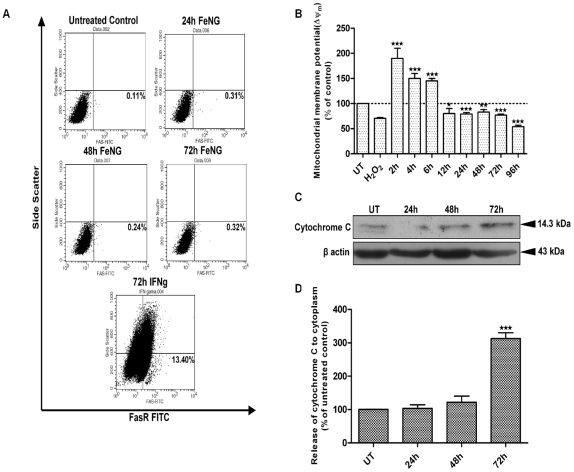
FeNG induces apoptosis through mitochondrial cell death pathway.(A) CEM/ADR5000 cells of both untreated and FeNG treated for indicated time or rIFN γ treated were labeled with anti FasR antibody. Immunofluorescence analysis was performed by flow cytometry. Representative data of 3 independent experiments is presented. (B) CEM/ADR5000 cells were treated with or without FeNG for indicated time, and mitochondrial membrane potential was measured after JC1 staining. The ratio of red fluorescence (mitochondrial JC-1) to green fluorescence (cytoplasmic JC-1) was used as a surrogate for mitochondrial potential. Data represent mean ± SD of three independent experiments. Statistically significant difference from untreated control at *P<0.05, **P<0.01, ***P<0.001, respectively. (C) Effect of FeNG on the release of cytochrome c. Western blot analysis of cytosolic extracts from CEM/ADR5000 cells treated with FeNG (10−4 M) for indicated hours. Cytosolic fraction was prepared as described in Materials and Methods. Membrane was probed with anticytochrome c antibody followed by incubation with peroxidase-conjugated secondary antibody. The protein was visualized by Lumi glow detection system. Membrane was blotted for β-actin (bottom panel) for loading correction. (D) Densitometric quantitation of cytochrome c levels in the cytoplasm. Immunoreactive bands were quantitated and expressed as the ratio of each band density to corresponding loading control (β actin) band density and values were represented after normalization to untreated control.